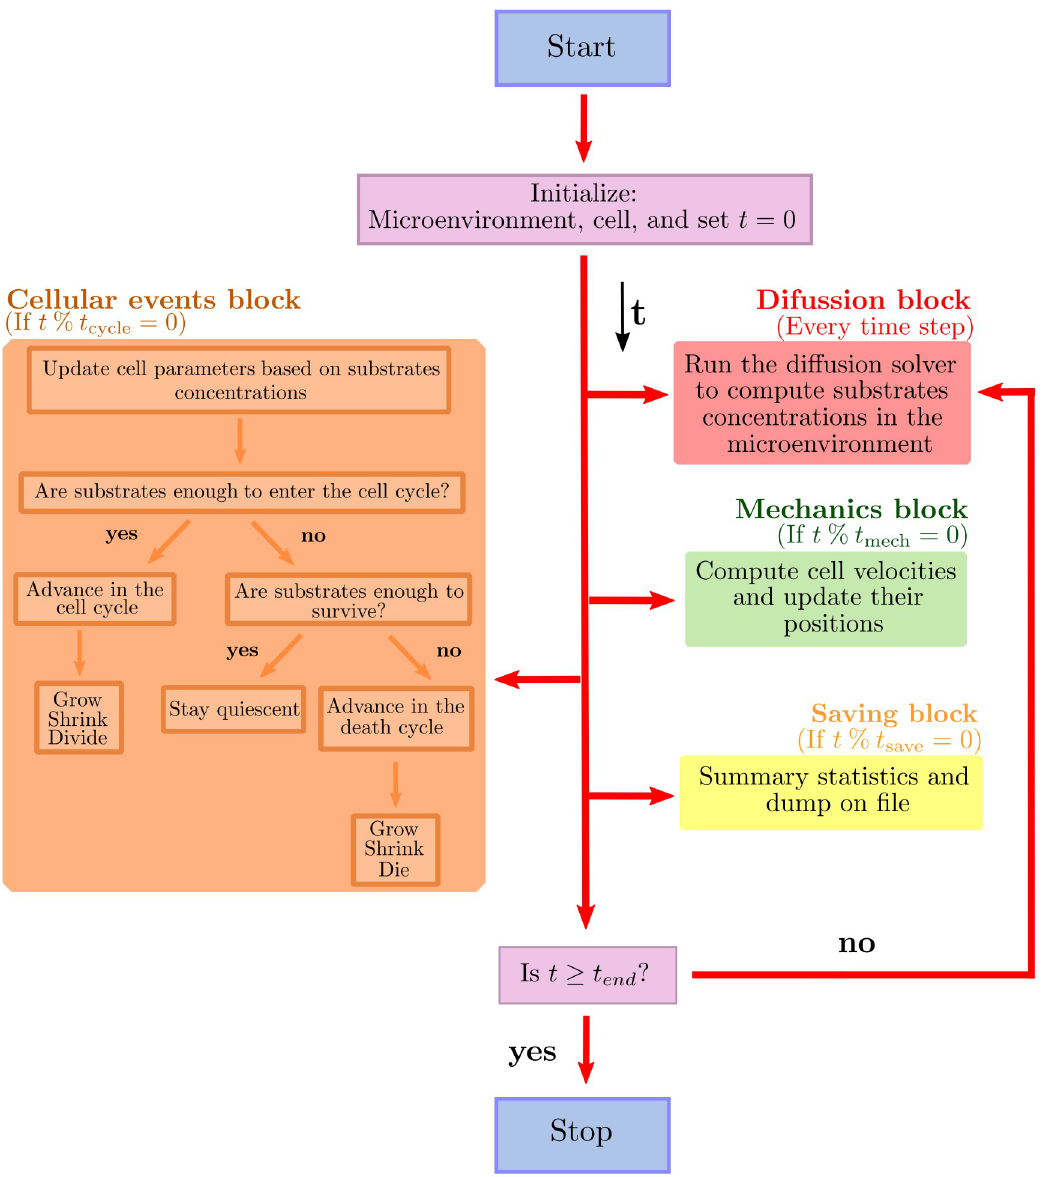
Fig 2. Main loop flow diagram. Blue box represents the start of the program. Red box represent the diffusion processes. Green box and orange box describe the cell mechanics and cycling processes respectively. Finally, yellow boxes represent the data saving process. After initializing the microenvironment, the cells, and the current simulation time t = 0, our model tracks (internally) t mech (the next time at which cell mechanics methods are run), t cycle (the next time at which cell processes are run), and t save (the simulation data output time), with output frequency Δ t save . % represents the modulo